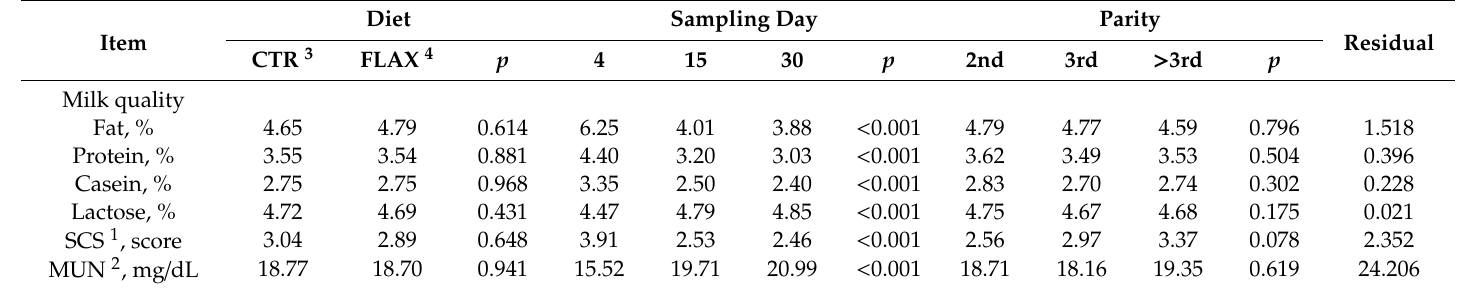
Table 3. E ff ect of flaxseed supplementation during dry period, sampling day, and parity on the early and commercial milk quality of Holstein cows during the first 30 d of the subsequent lactation.